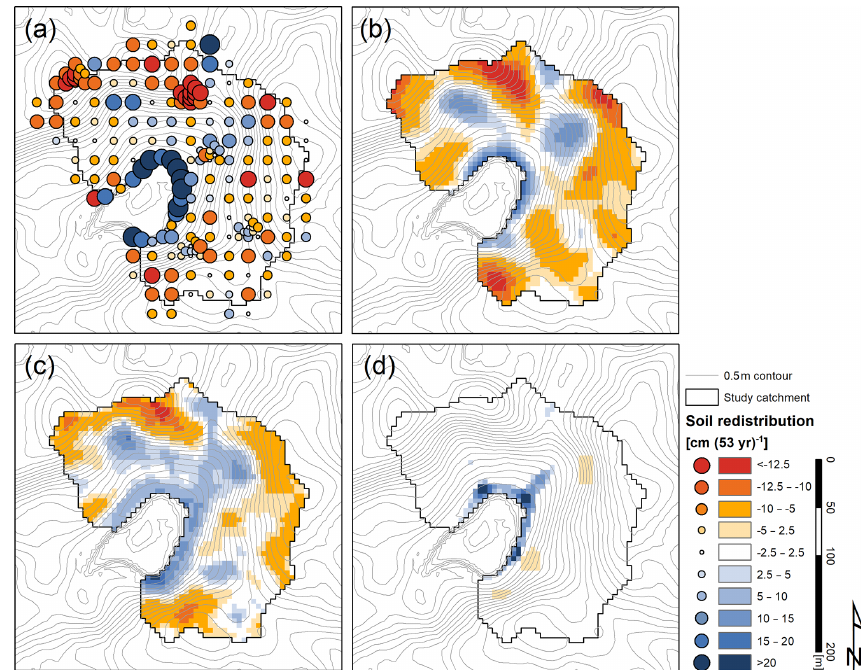
Figure 7. The figure consists of four parts. (a) Soil redistribution derived from 239 + 240 Pu top and subsoil measurements using 43Bqm − 2 as the reference inventory; (b) geostatistically interpolated soil redistribution based on 239 + 240 Pu point measurements; (c) modelled tillage erosion with a tillage transport coefficient ( k til ) of 350kgm − 1 ; (d) modelled water erosion according to reference parameterisation ( k tc : 150; also see Table